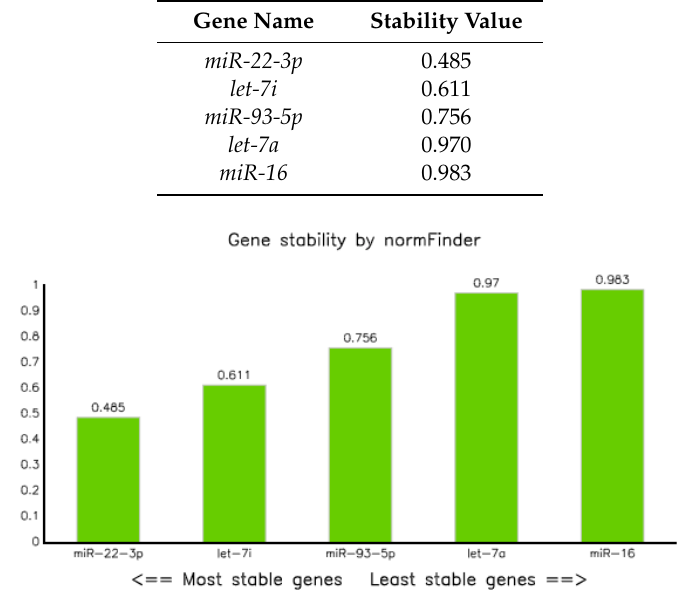
Table 4. Stability value of candidate miRNA calculated using NormFinder application software.